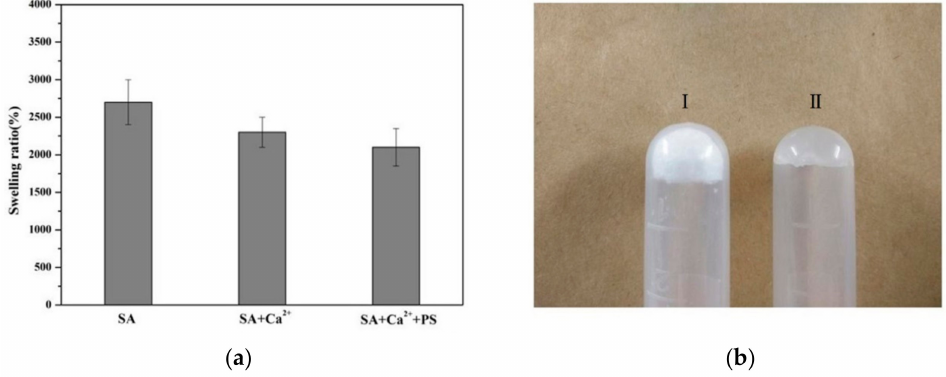
Figure 4. Comparisons of hydrogels ( a ) swelling ratio and ( b ) dry-wet contrast